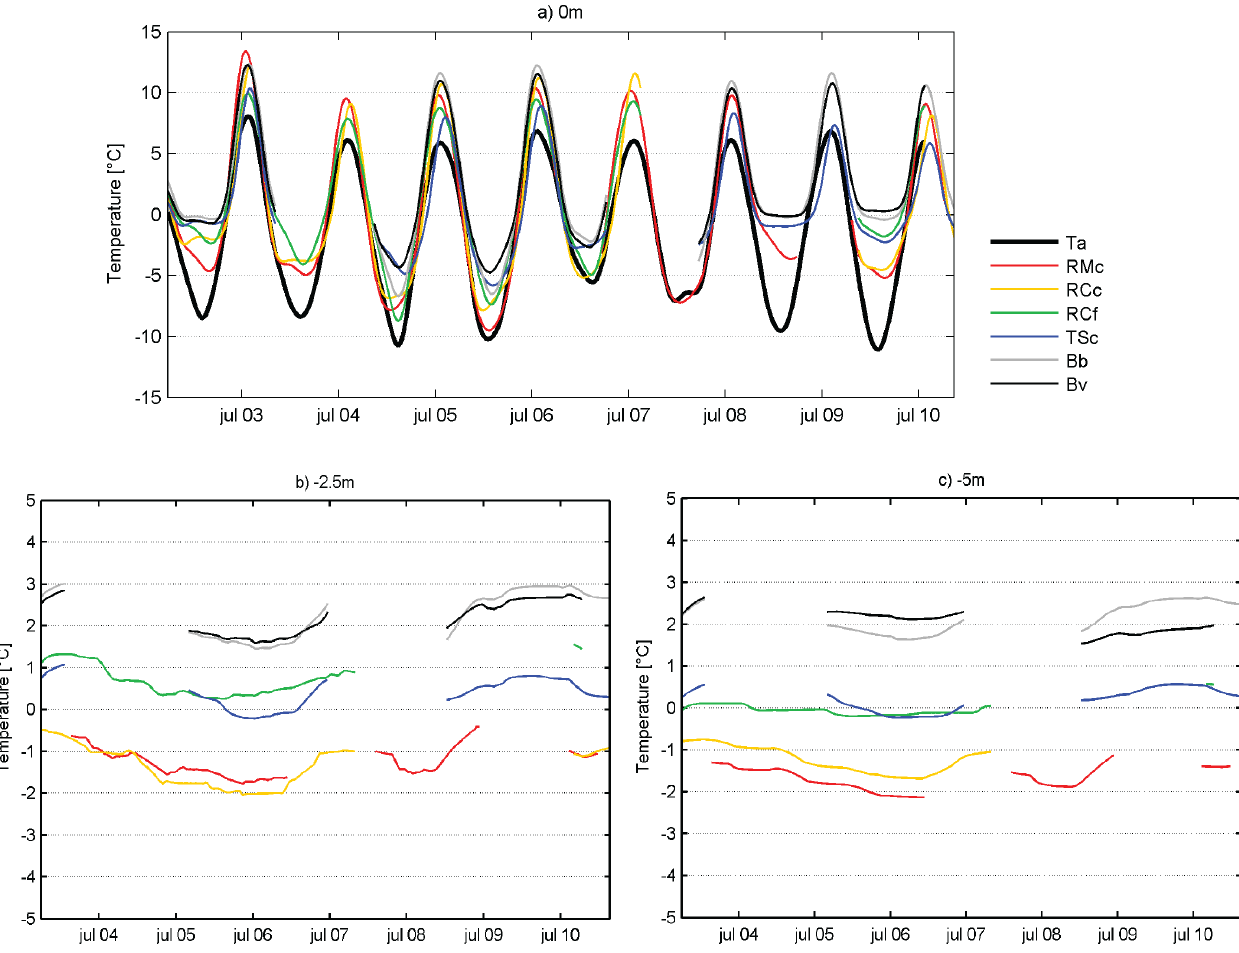
Fig. 4. Filtered temperatures from 2002–2010 for all sites and different depths: (a) air temperature and ground surface temperature, (b) sub- surface temperature at − 2.5m, and (c) subsurface temperature at − 5m. For the air temperature and ground surface temperature, a low-pass Gaussian filter was applied (a) , and for the subsurface temperatures (b) and (c) a 365-day moving-average was used. Data gaps are due to technical problems with the data logger.